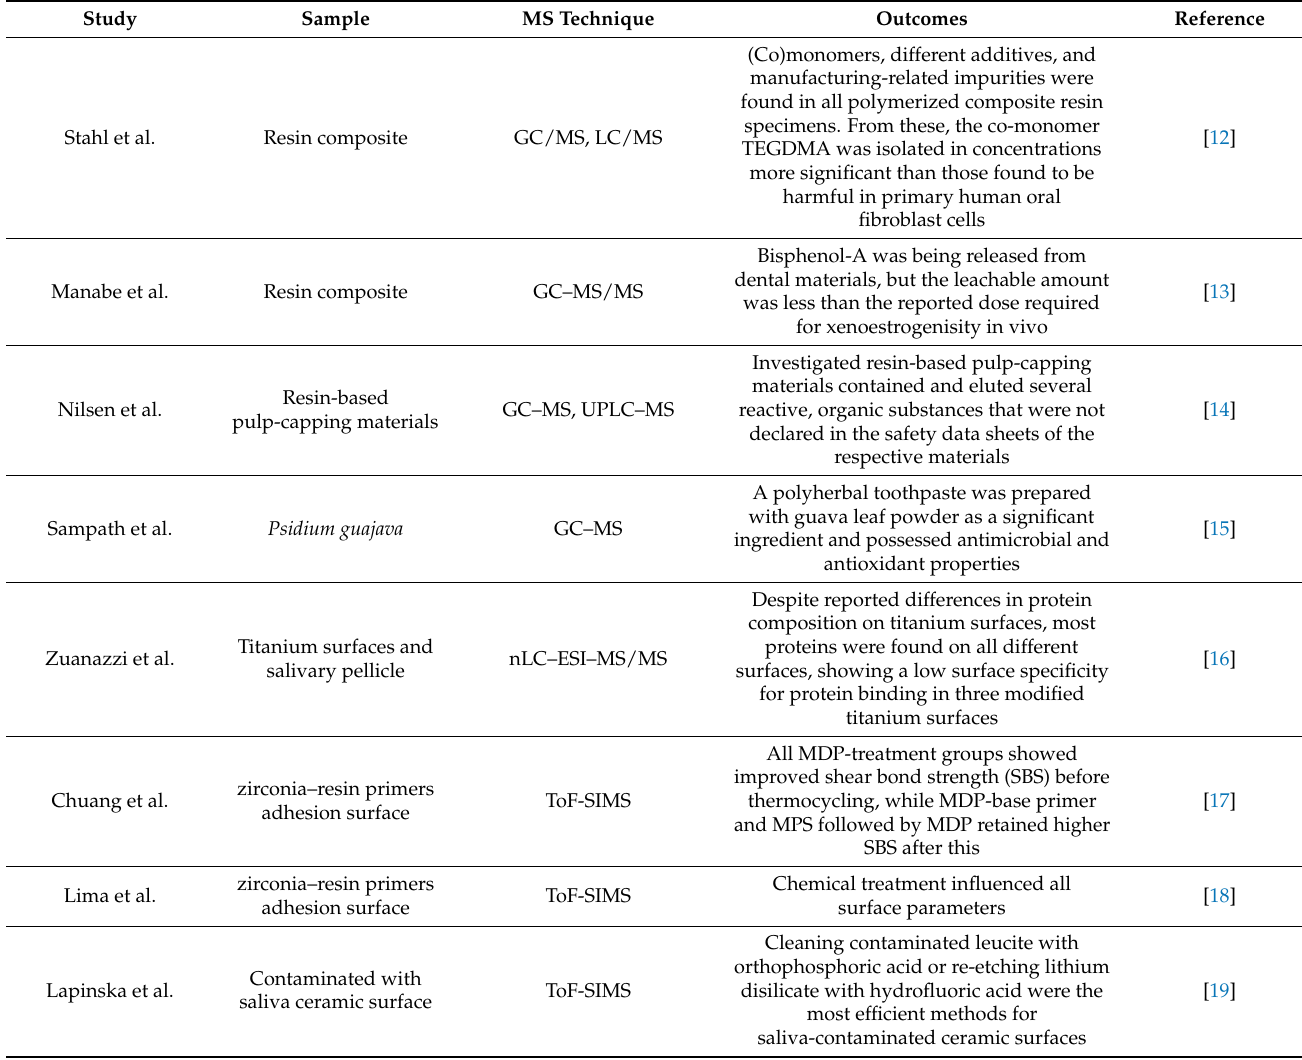
Table 1. Use of MS techniques for dental materials laboratory